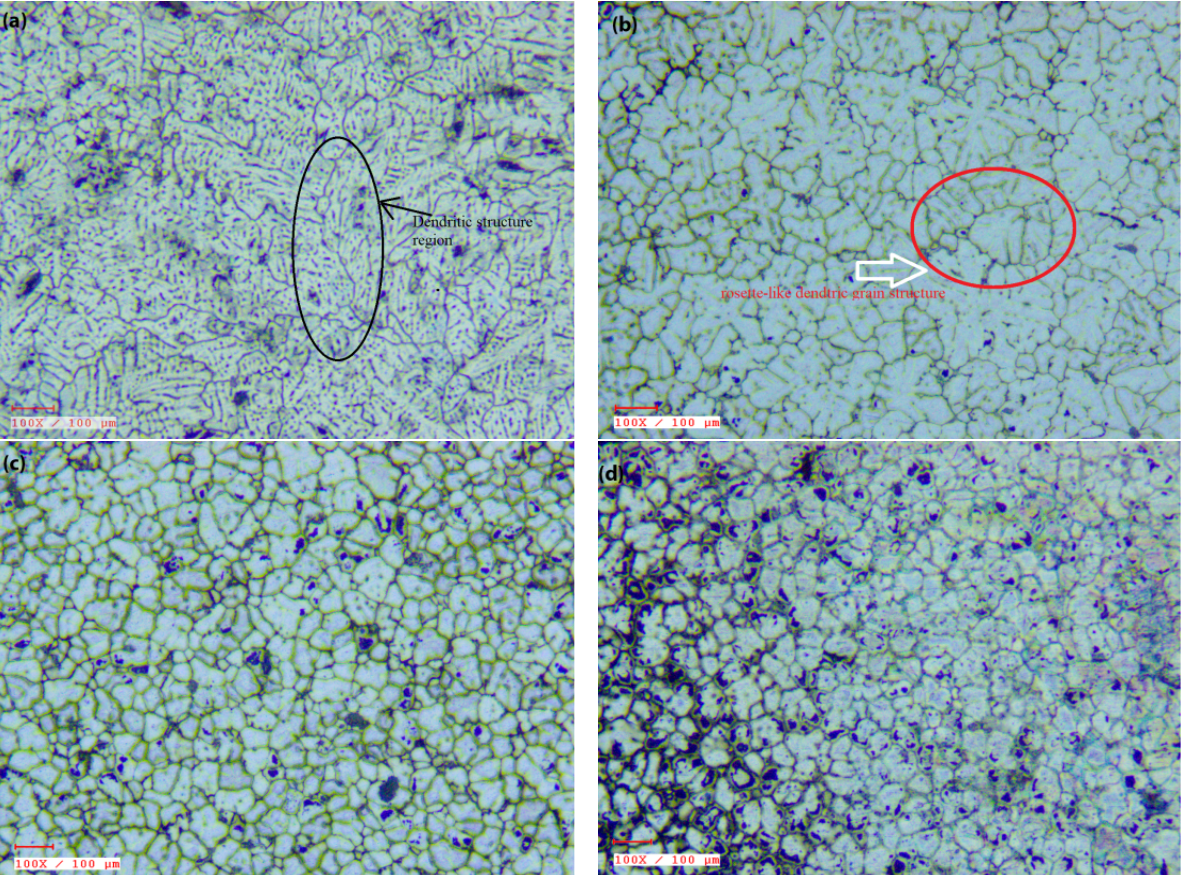
Figure 2: Optical images of as-cast AA7010/TiB 2 composite (a) 0% TiB 2 , (b) 5% TiB 2 , (c) 7.5% TiB 2 and (d) 10% TiB